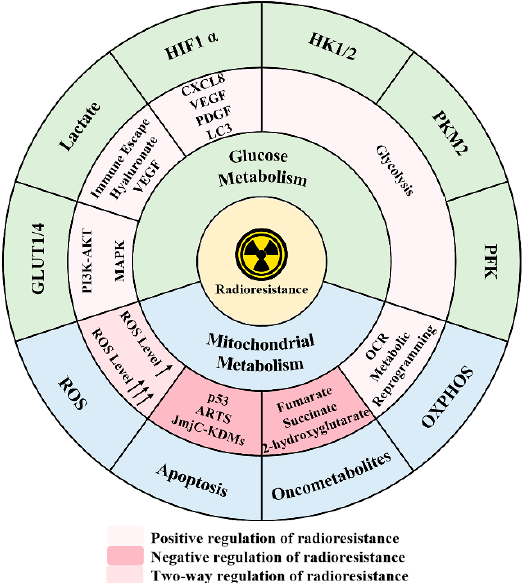
Figure 1. A schematic model illustrating the effects of two major metabolisms on radioresistance. Six targets in glucose metabolism have the most significant impact on radiation resistance, regulating their corresponding molecules or processes to intervene in the therapeutic effect. In general, small-molecule inhibitors can be used to help IR restore the expected efficacy, and there are several approved drugs currently available for clinical treatment. The effects of mitochondrial metabolism on radiation resistance can be summarized in four aspects, the details of which are presented below.